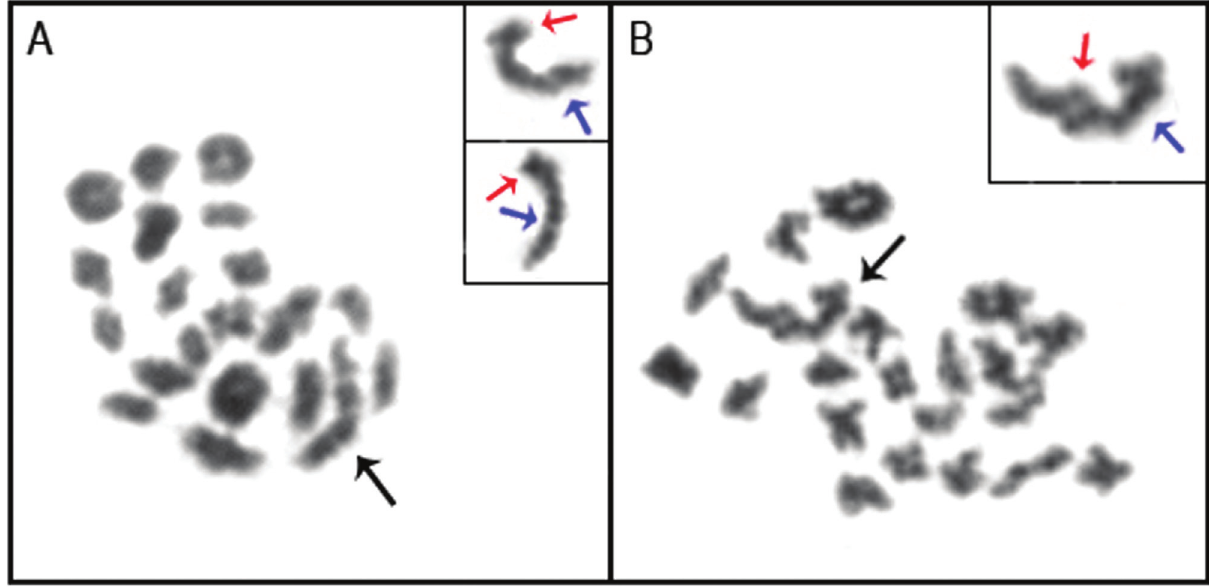
Figure 3 - Meiotic chromosomes of Brachyhypopomus pinnicaudatus (A) and B. n. sp. FLAV (B) after conventional staining. Black arrows indicate the sexual trivalent. Boxes: red arrows indicate chiasmata; blue arrows indicate end-to-end